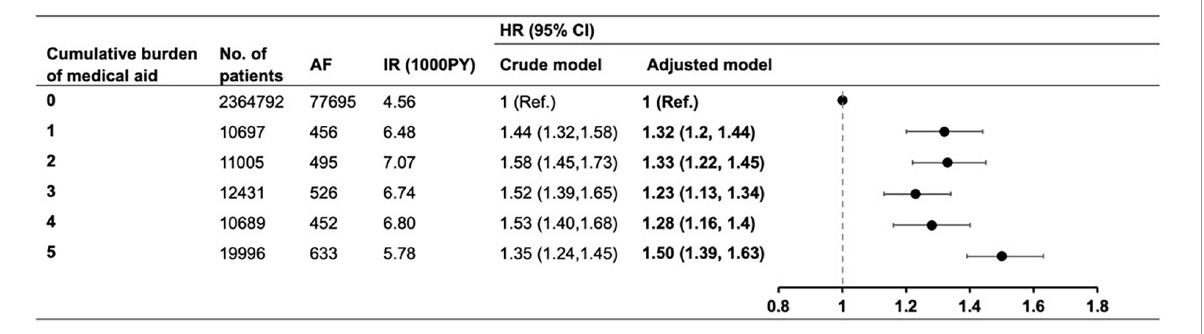
FIGURE2 The risk of atrial fibrillation according to the cumulative burden of medical aid. Adjusted model corrected for age, sex, body mass index, blood glucose level, smoking, drinking, regular physical activity, hypertension, dyslipidemia, insulin use, ≥ 3 antidiabetic medication, and ≥ 5 years of diabetes mellitus duration. AF, atrial fibrillation; IR, incidence rate; PY, person-year; HR, hazard ratio; CI, confidence interval.